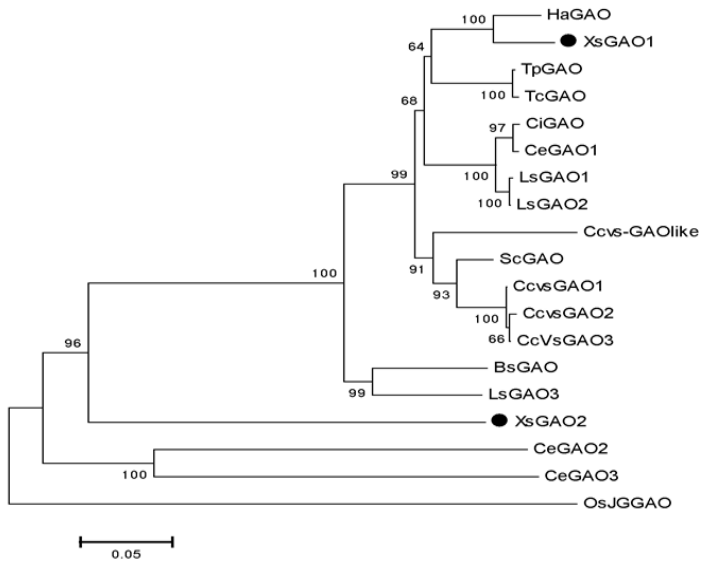
Figure 3. Phylogenetic tree analysis of GAOs is shown. OsJG GAO used as outgroups, which is from Oryza sativa Japonica Group. Bootstrap value were shown in percentage values from 1000